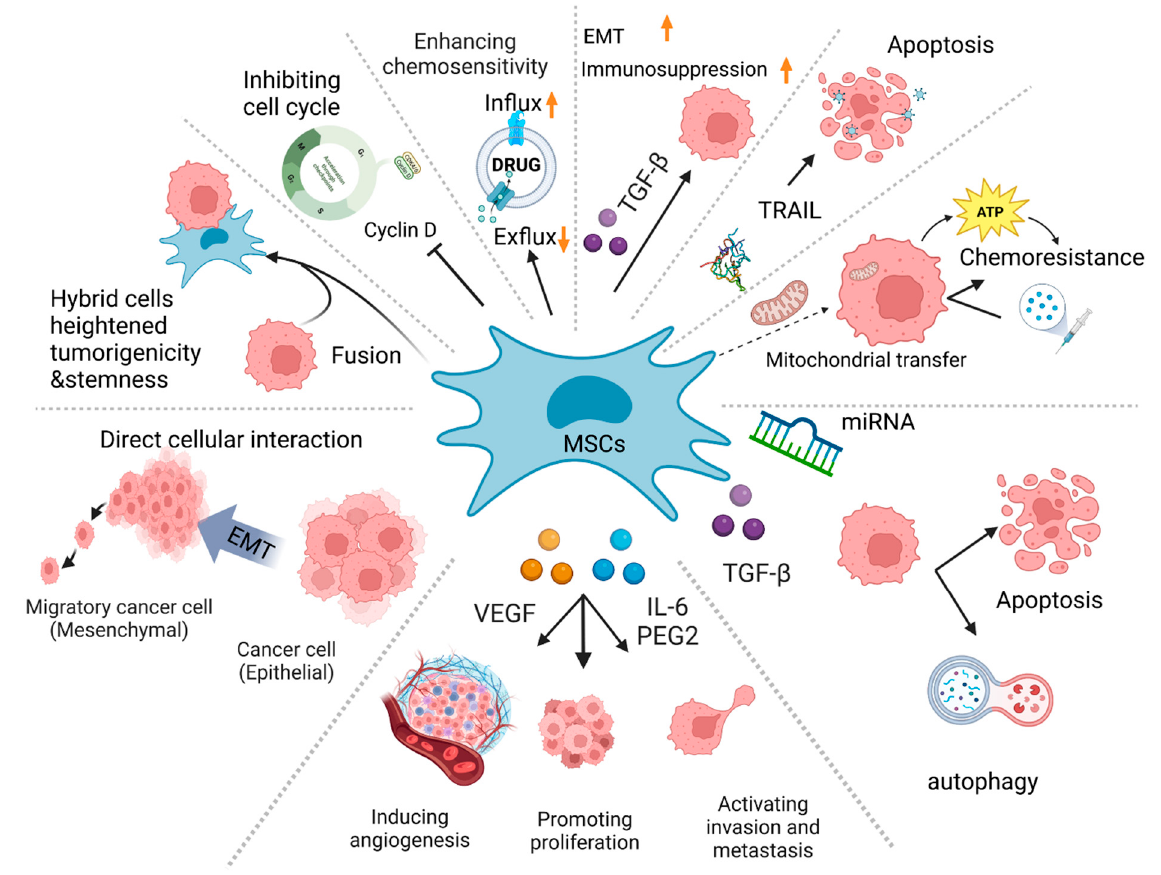
Figure 1. This schematic diagram illustrates how mesenchymal stem cells (MSCs) can interact with triple-negative breast cancer (TNBC) cells, such as through the secretion of soluble factors, transfer of mitochondria, and fusion. These interactions can influence the proliferation, migration, invasion, metastasis, angiogenesis, and drug resistance of TNBC cells. Furthermore, they can also activate signal pathways and molecular mechanisms that could be targeted for therapeutic interventions.